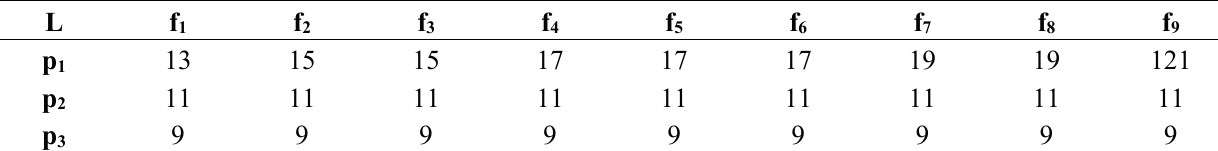
Table 5. Image sizes using Column-based Image Coding.